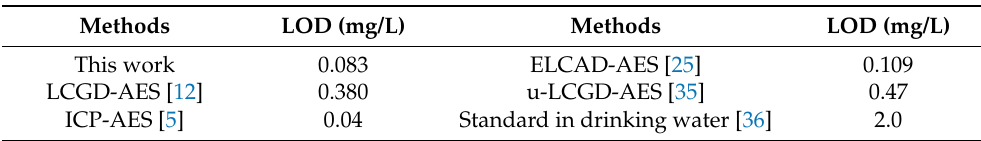
Table 2. Comparison of LOD obtained by this work (APNDP) with other techniques for detecting trace heavy metal Cu.